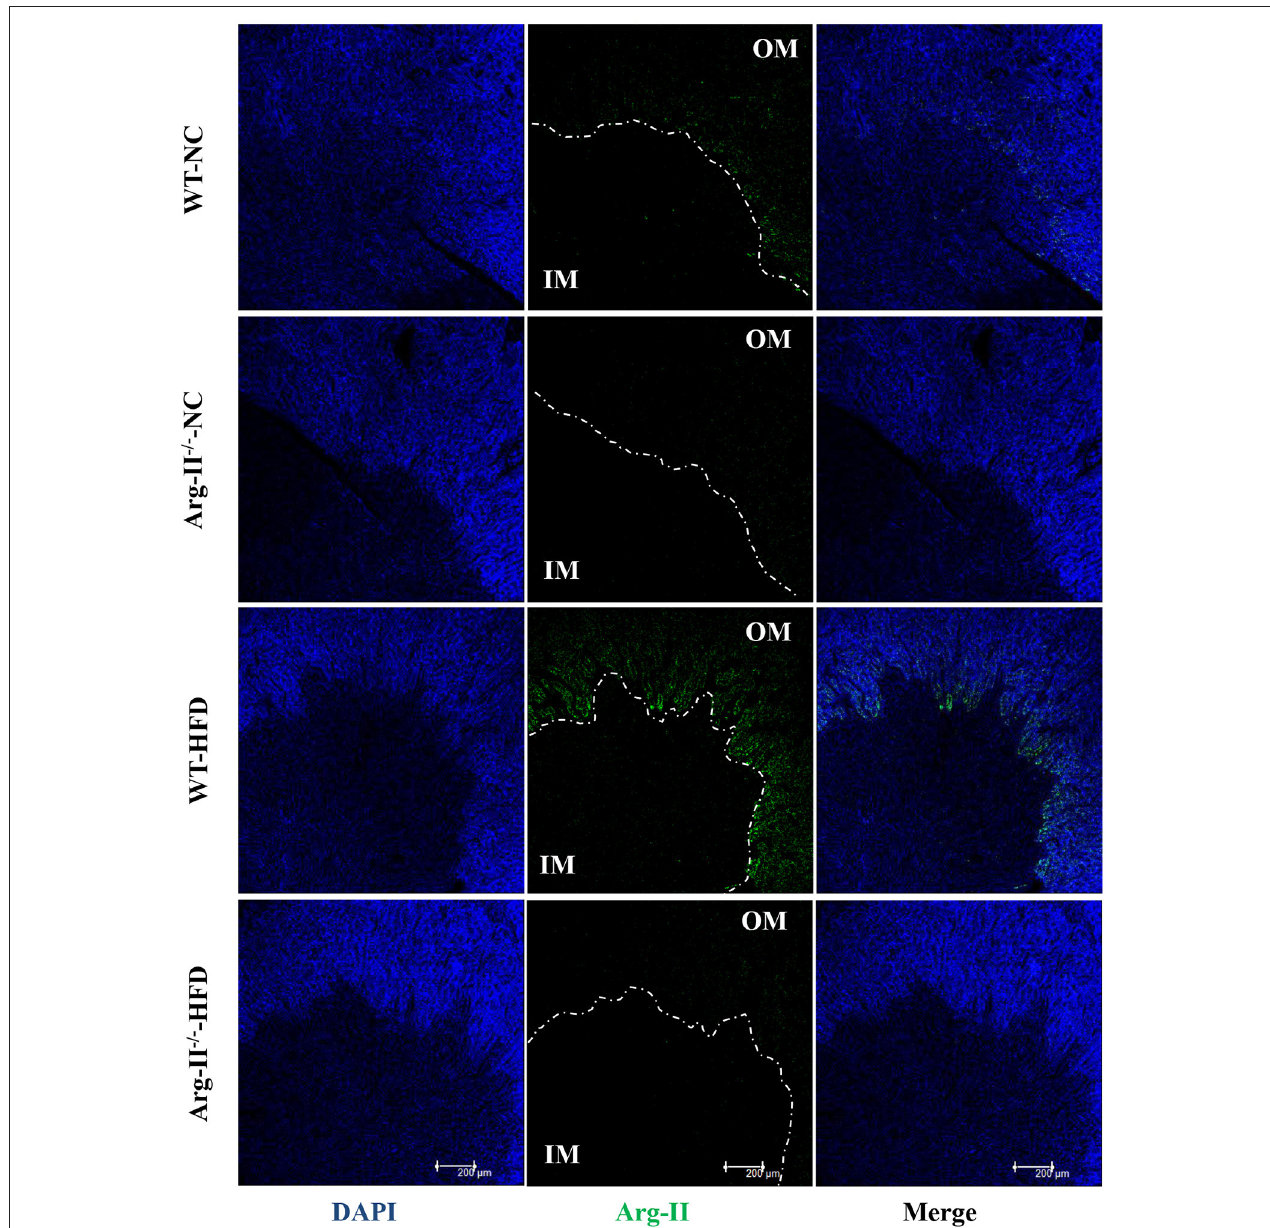
FIGURE 2 | Arg-II is expressed in outer medulla of kidney. Confocal immunofluorescence staining of Arg-II (green) and DAPI (blue) in the kidney of WT and Arg-II − / − mice fed either a normal chow (NC) or high fat diet (HFD). Representative images of individual staining and merged images are shown ( n = 4 for each group). OM, outer medulla; IM, inner